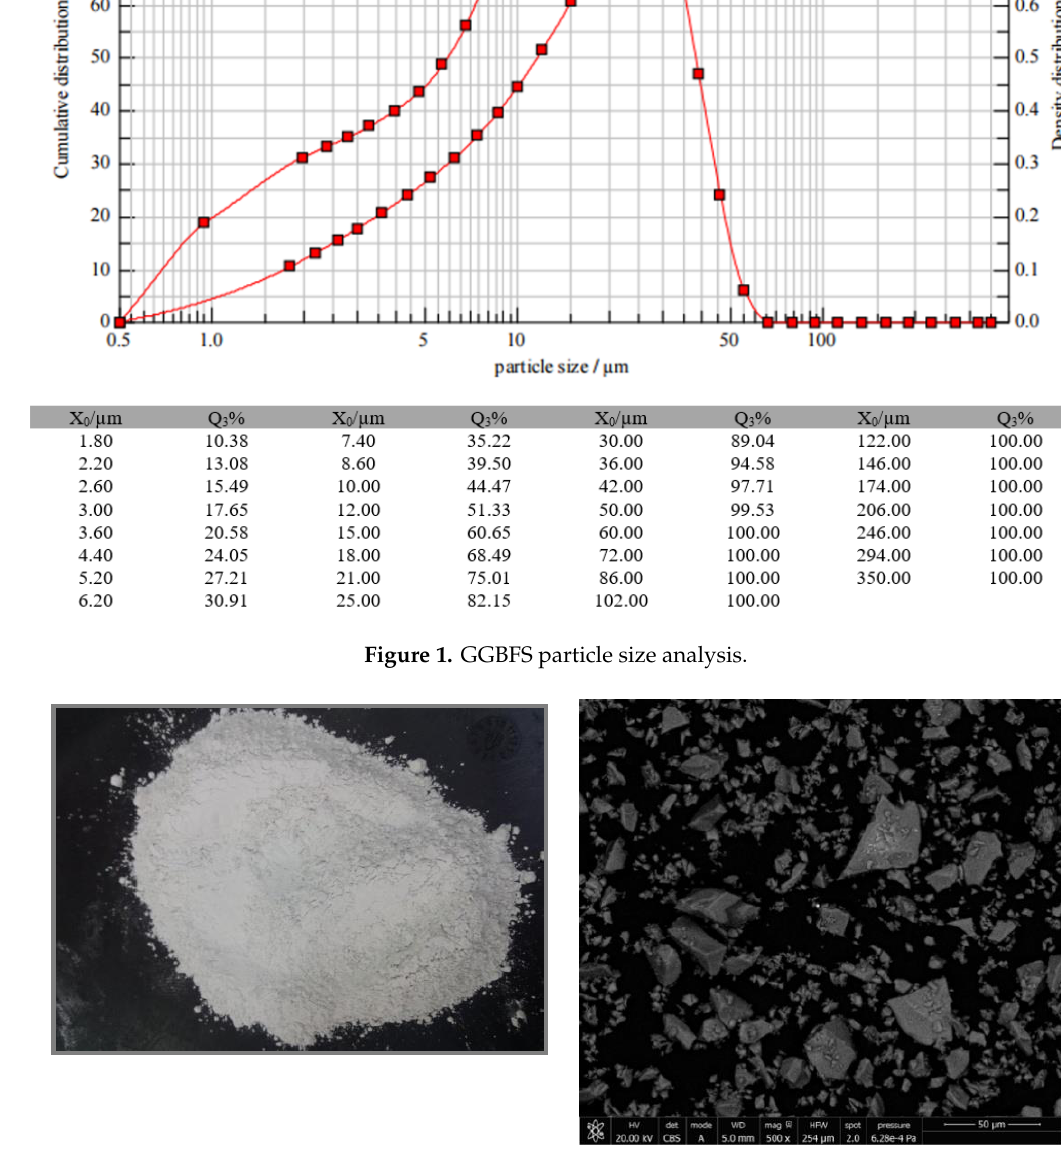
Figure 2. GGBFS SEM micrograph.